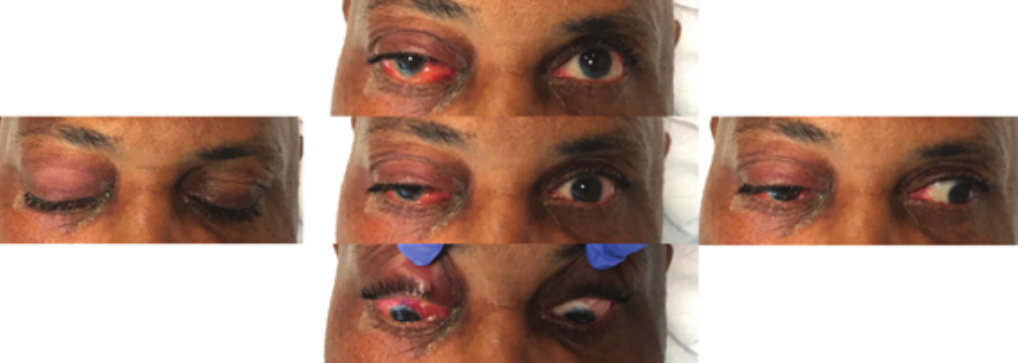
Figure 1. External photograph of the affected eye on the day of presentation, demonstrating periorbital edema, erythema, conjunctival injection, and chemosis.